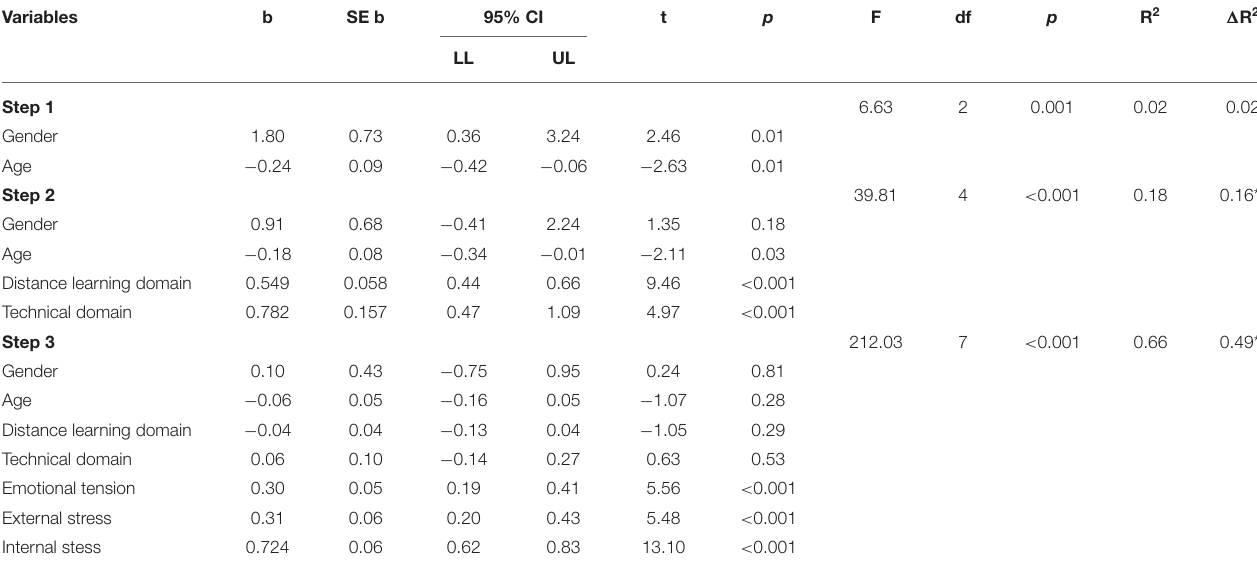
TABLE 2 | Results of stepwise regression for